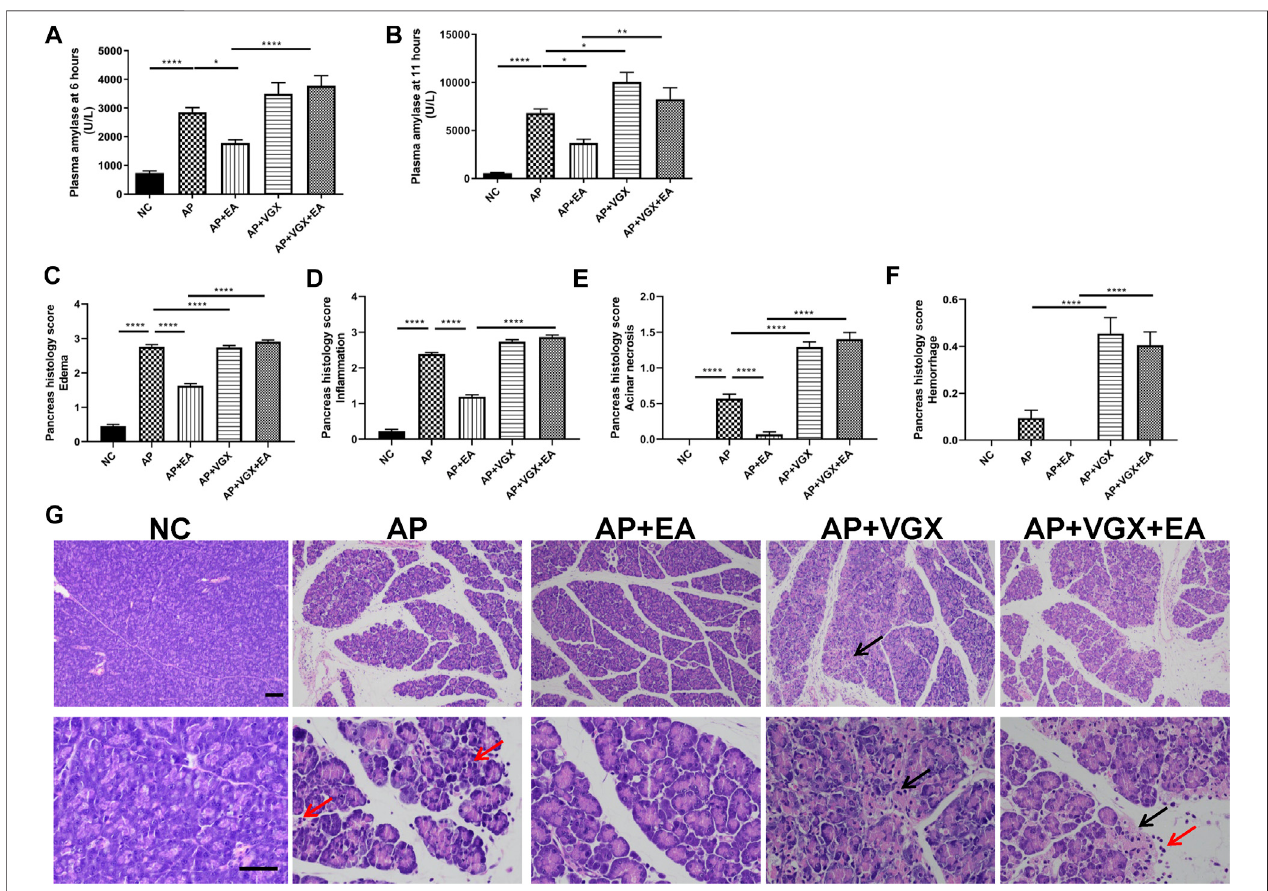
FIGURE 2 | EA alleviates the severity of caerulein AP mice. (A) Plasma amylase activity at 6 h after the fi rst caerulein injection. (B) Plasma amylase activity at 11 h. (C) The pancreas histological score of edema. (D) The pancreas histological score of in fl ammation. (E) The pancreas histological score of acinar necrosis. (F) The pancreas histologicalscore of hemorrhage. (G) Representative H&E staining of pancreas sections (scale bars: 100 μ m). Black arrow represents pancreas necrosis, and red arrow represents in fi ltrating cells, n (cid:1) 7 – 10. Bars show mean ± SEM. * p < 0.05, ** p < 0.01, and **** p < 0.0001. NC, normal control; AP, acute pancreatitis; EA, electroacupuncture; VGX,